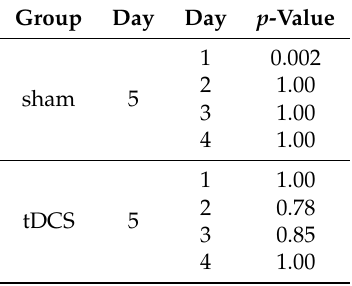
Table 4. Comparison between Day 5 and the rest of the days for each